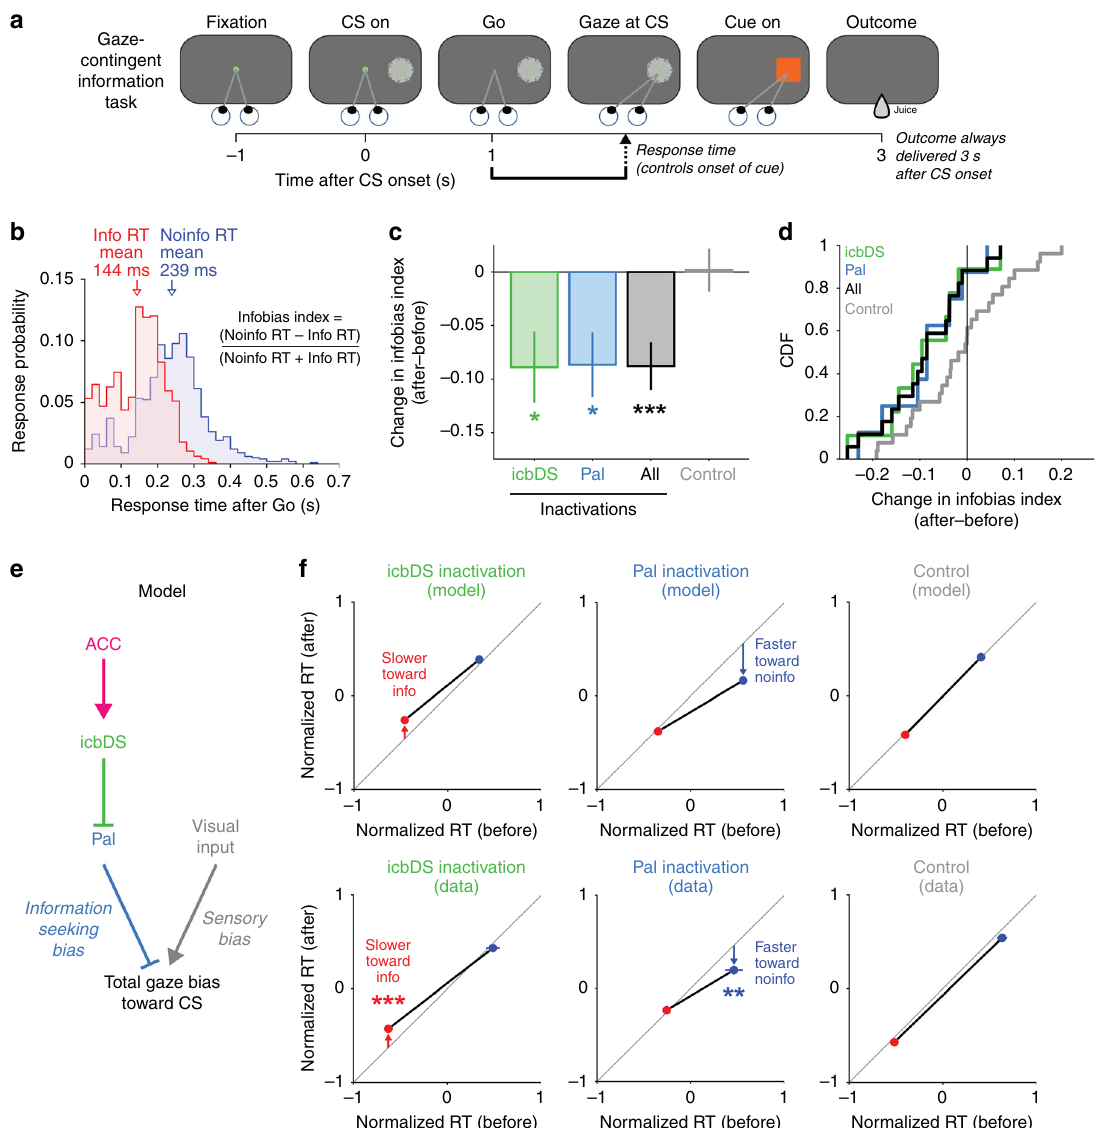
Fig. 7 Perturbation of network activity impairs information seeking. a Gaze-contingent information task. Monkeys were shown a CS, waited for a go signal, and then were allowed to gaze at it. Gazing at an Info or Noinfo CS caused it to be replaced with an informative or noninformative cue. Regardless of gaze, the outcome was always delivered a fi xed time after CS onset. b RT distribution for animal B. The animal had much faster RTs for Info trials (red) than Noinfo trials (blue). The animal often anticipated the time that information would become available, as indicated by the prevalence of anticipatory saccades especially on Info trials. This histogram includes all RTs collected when inactivations were not being performed ( n = 1966), excluding four outliers from Noinfo trials (RTs = 0.741, 0.748, 1.326, 1.335 s). c Muscimol inactivation effect on RTs to contralateral CSs, quanti fi ed as the change in Infobias